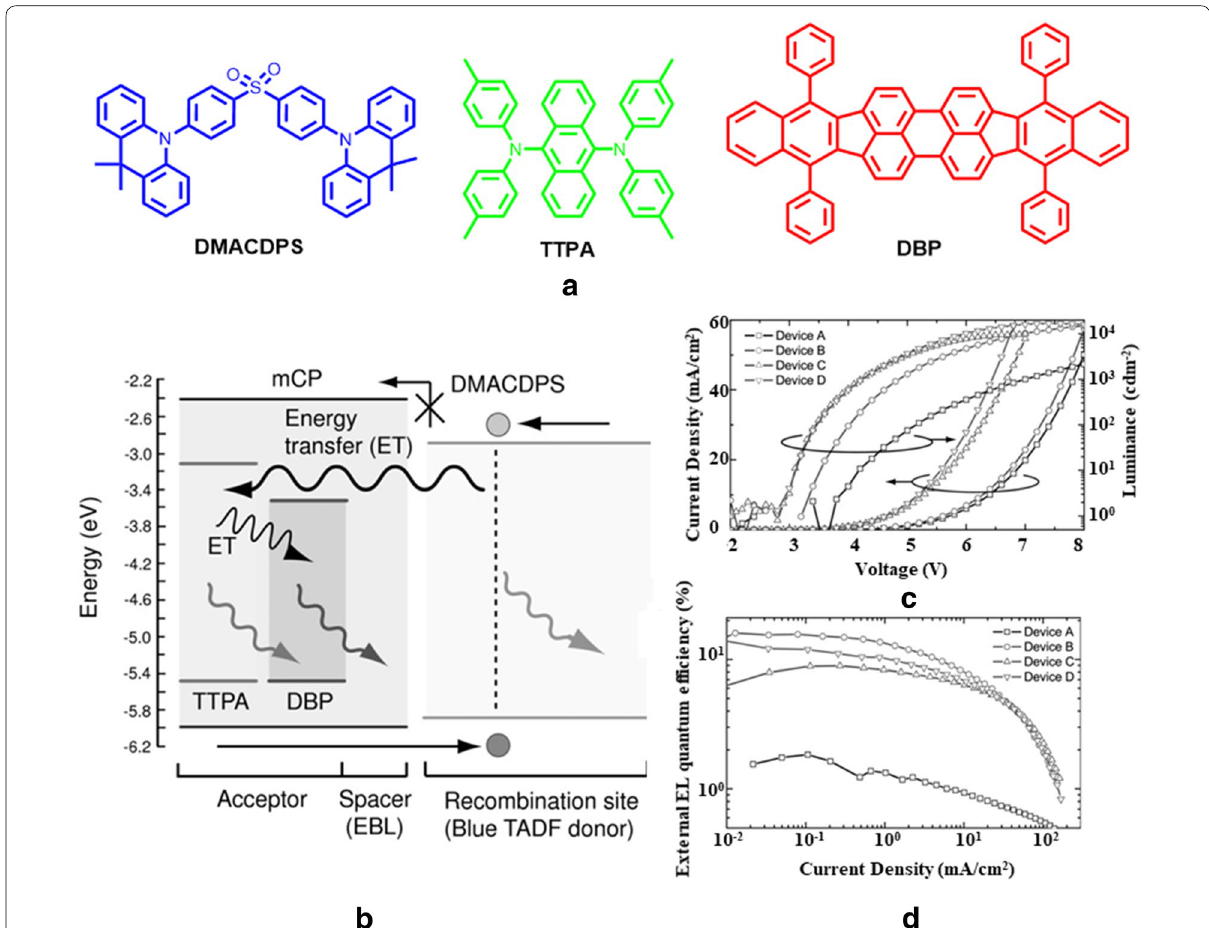
Fig. 15 a Chemical structures of emissive materials, b FRET mechanism between DMACDPS and TTPA (green) and DBP (red) under electrical excitation [spacer layer mCP (2 nm)], c current density and luminance vs. voltage spectra and d external EL quantum efficiency vs. current density spectra of the OLEDs (Reproduced with permission from Ref. [46] Copyright 2015, ©WILEY–VCH Verlag GmbH &amp; Co. KGaA,